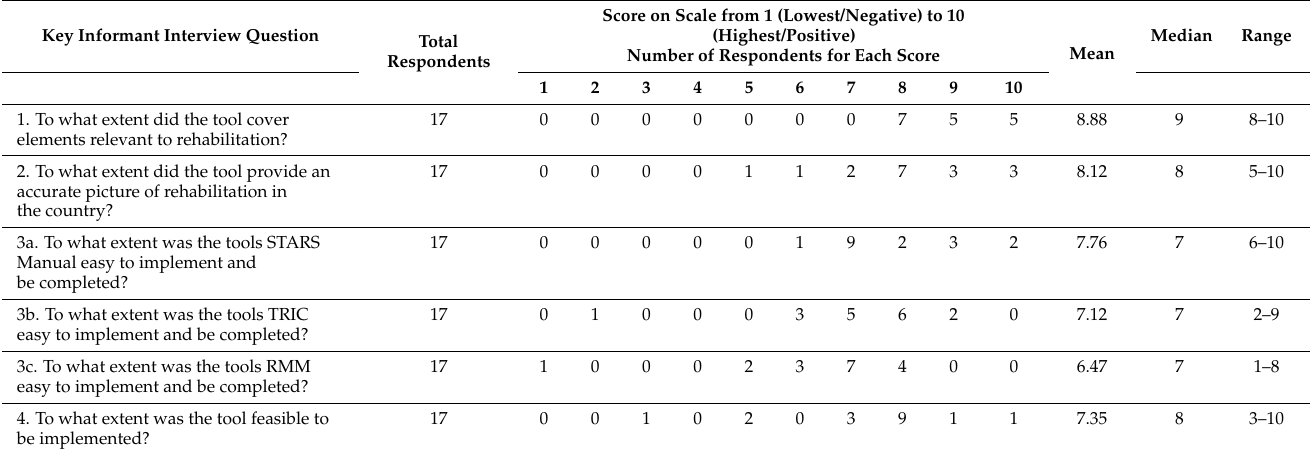
Table 3. Key Informant Interview—Results of Rating